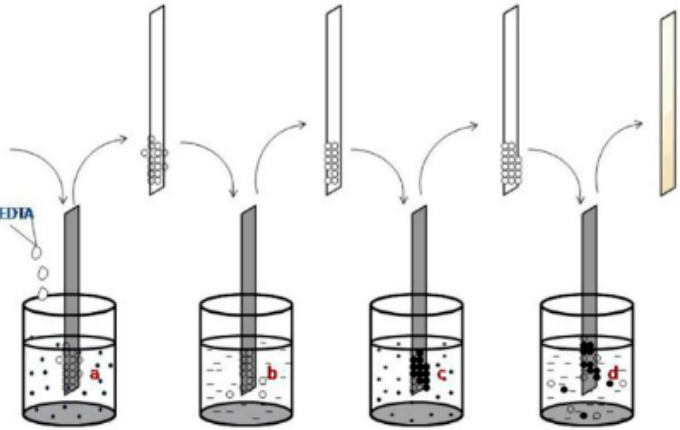
Figure 1. The scheme of SILAR-deposited tin sulfide thin films reproduced with permission from [31], Springer, 2017. ( a ) Immersion in the Sn(NO 3 ) 2 solution. ( b ) Rinse in the distilled water. ( c ) Immersion in the Na 2 S solution. ( d ) Rinse in the distilled water.